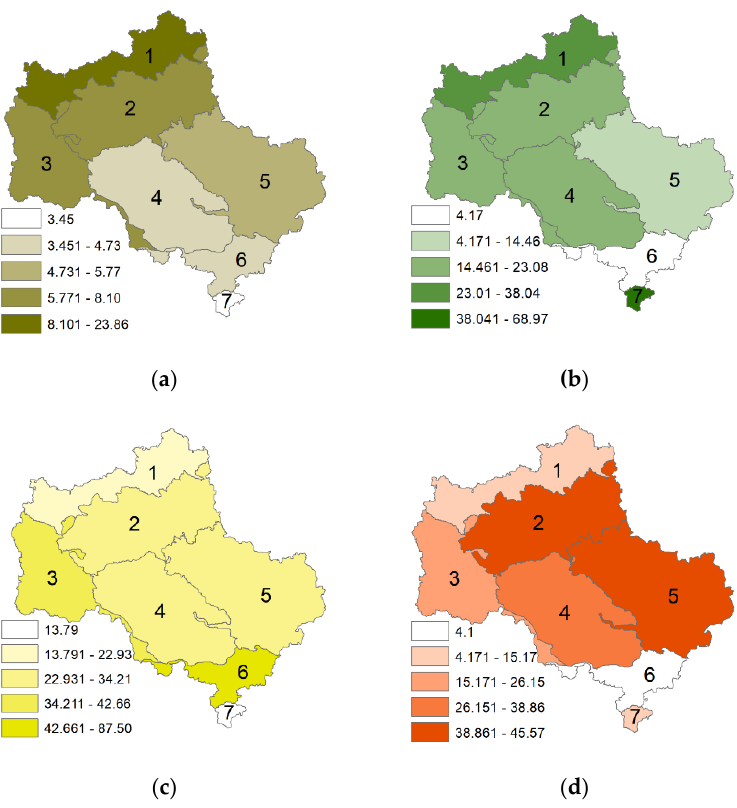
Figure 9. Proportion (%) of association groups with breakdown by province: ( a ) DShG, ( b ) Sh, ( c ) ShBh and ( d ) Bh; province numbers: 1—Verkhnevolzhskaya, 2—Moskovskaya, 3—Smolenskaya, 4—